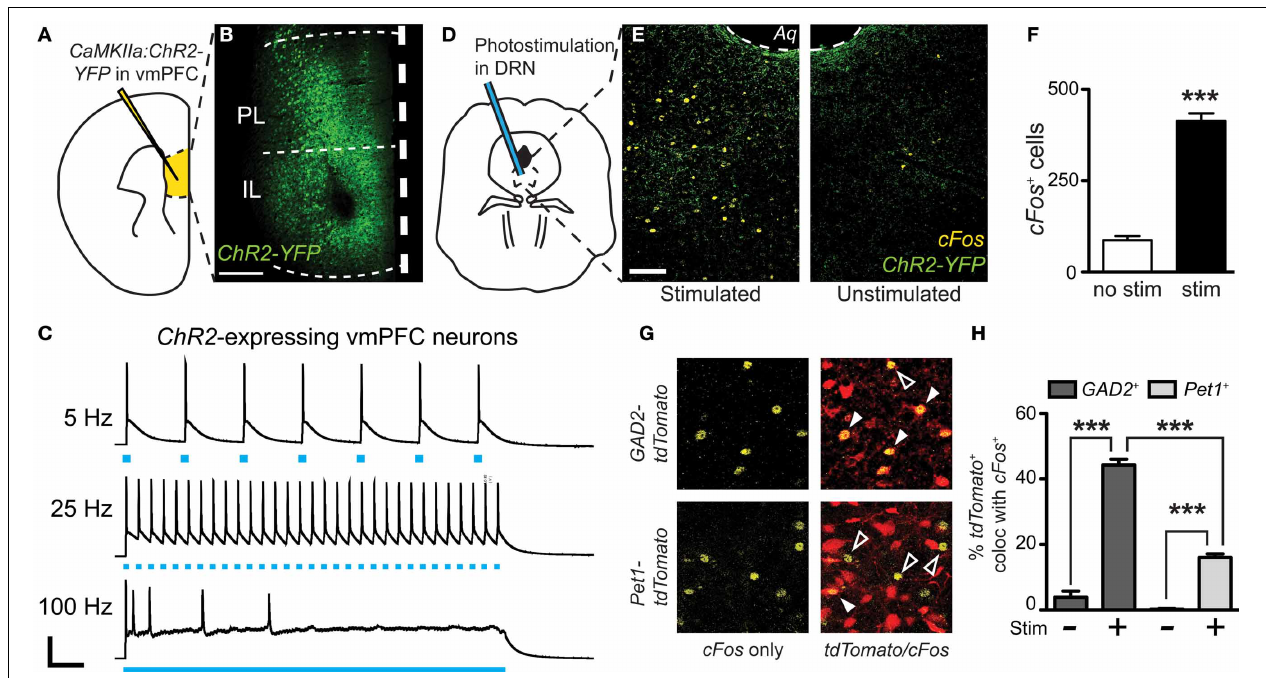
FIGURE 4 | Preferential cFos induction in GABA neurons after photostimulation of vmPFC terminals in the DRN. (A) CaMKIIa -driven ChR2-YFP was injected in the vmPFC of GAD2-tdTomato or Pet1-tdTomato mice. (B) After allowing 6 weeks, robust expression of ChR2-YFP was achieved. Scale bar 25 μ m. (C) Fluorescent neurons in layer V of the vmPFC were recorded. Current-clamp traces of YFP + vmPFC neurons demonstrate temporal fidelity of ChR2 -mediated photocurrents at 5 and 25Hz, and loss of precision at 100Hz. Scale bar 40pA, 0.2s. (D) At the same time point post-injection (6 weeks), vmPFC terminals in the DRN were photostimulated for 20min using 473nm light (10mW, 25Hz, 10ms pulse width). (E) cFos